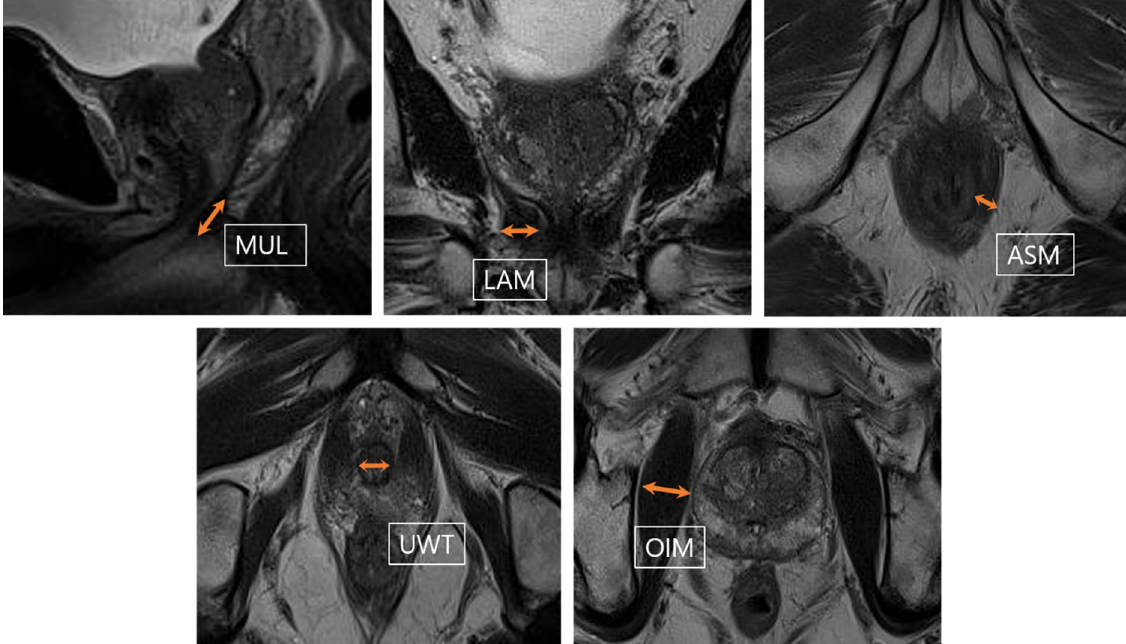
Figure 1. Pelvic floor magnetic resonance imaging parameters: membranous urethral length (MUL), levator ani muscle (LAM), urethra wall thickness (UWT), anal sphincter muscle (ASM), and obturator internal muscle (OIM).